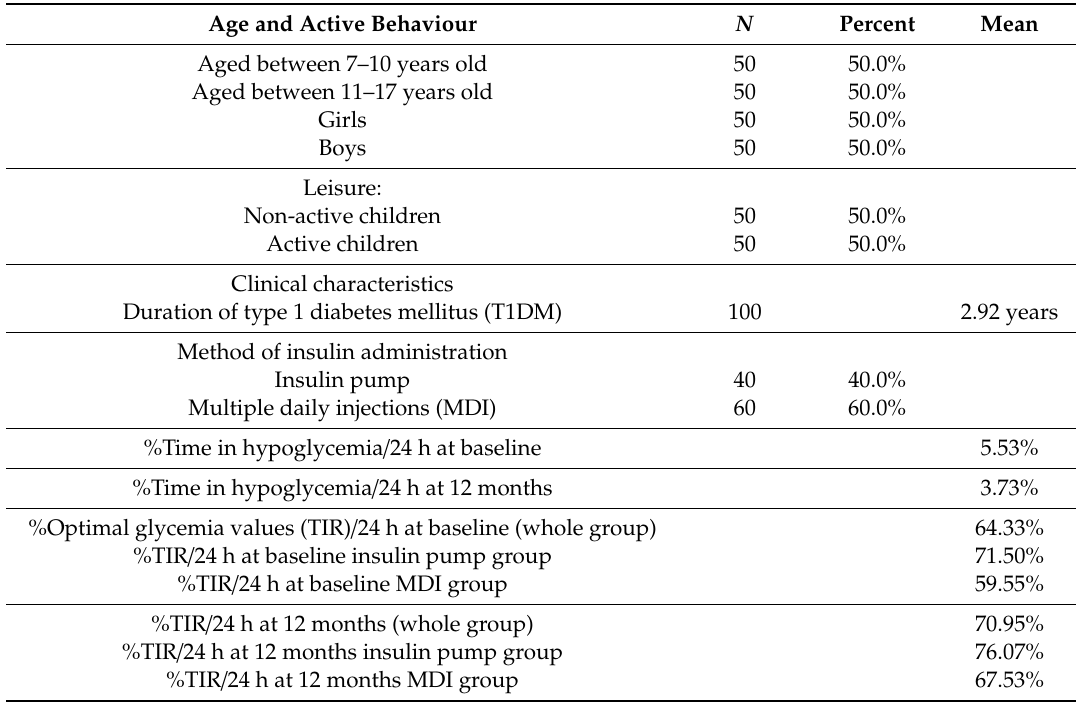
Table 1. Descriptive statistics of the measured